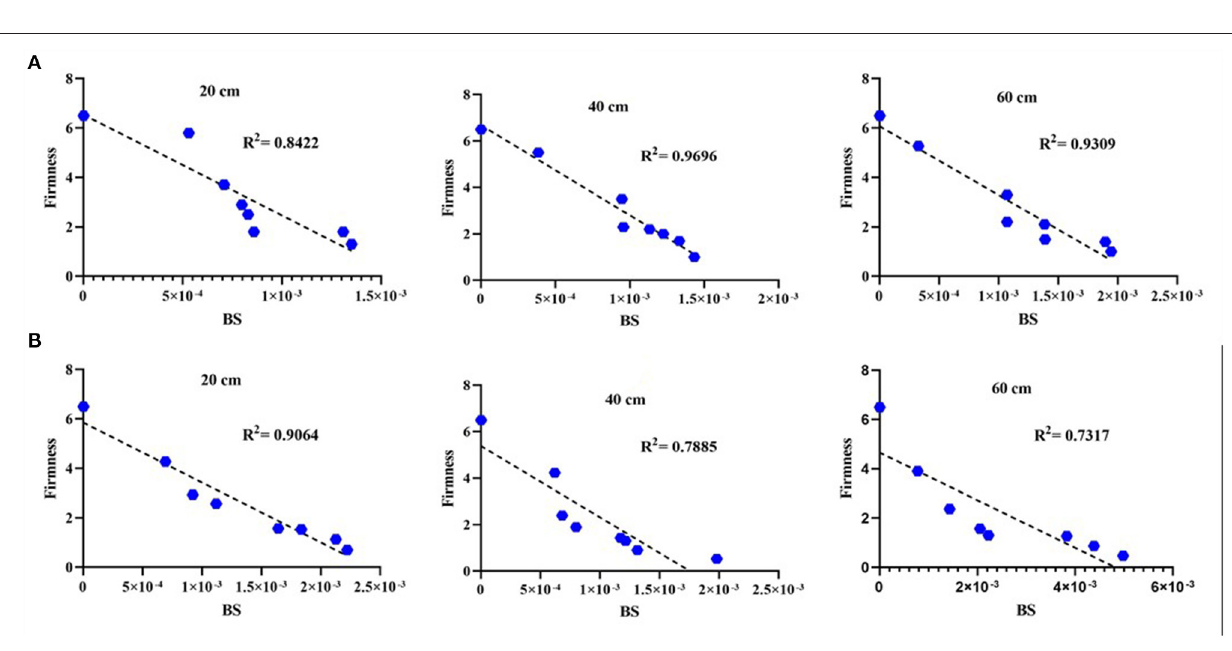
Frontiers in Sustainable Food Systems |